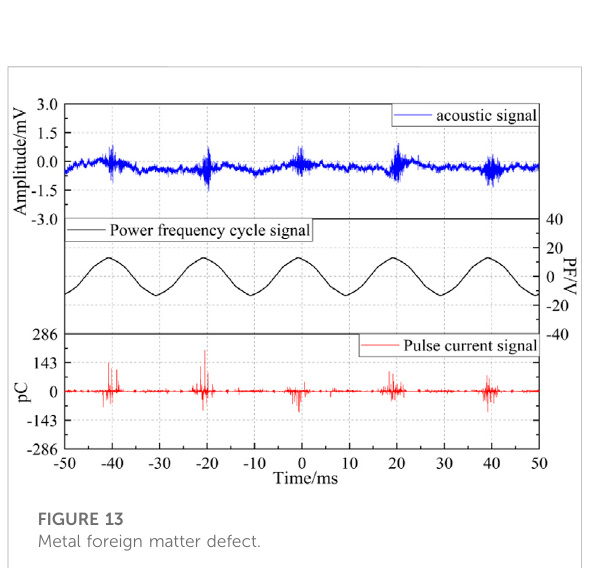
FIGURE 14 Surface discharge